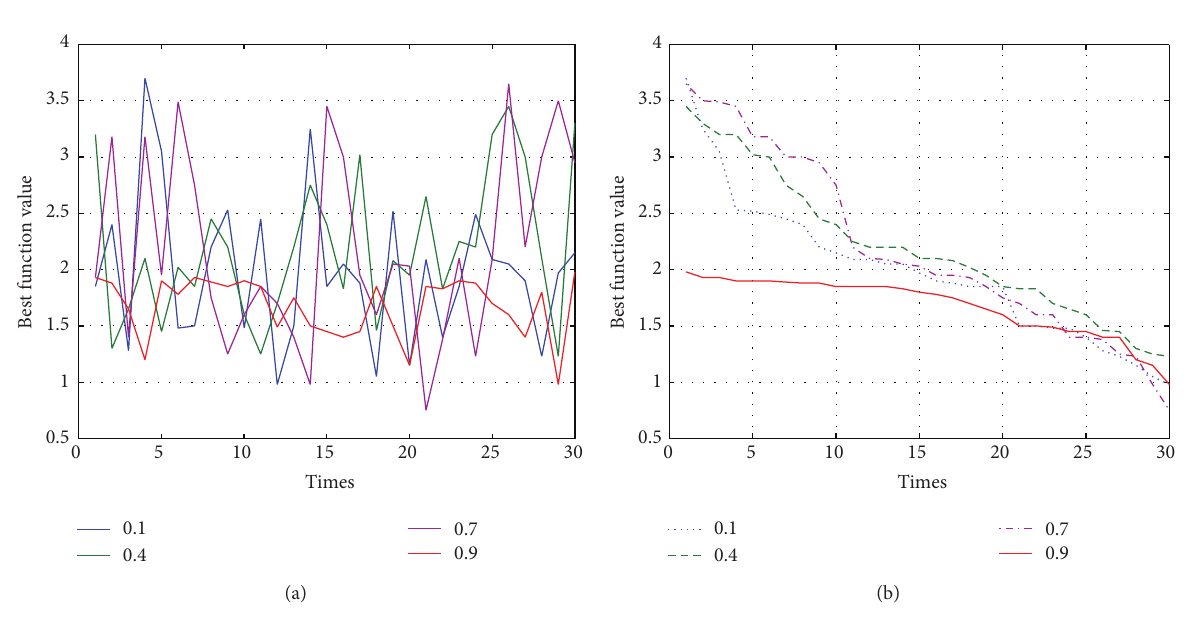
Figure 3: Optimization results on different values 𝑝 𝑐